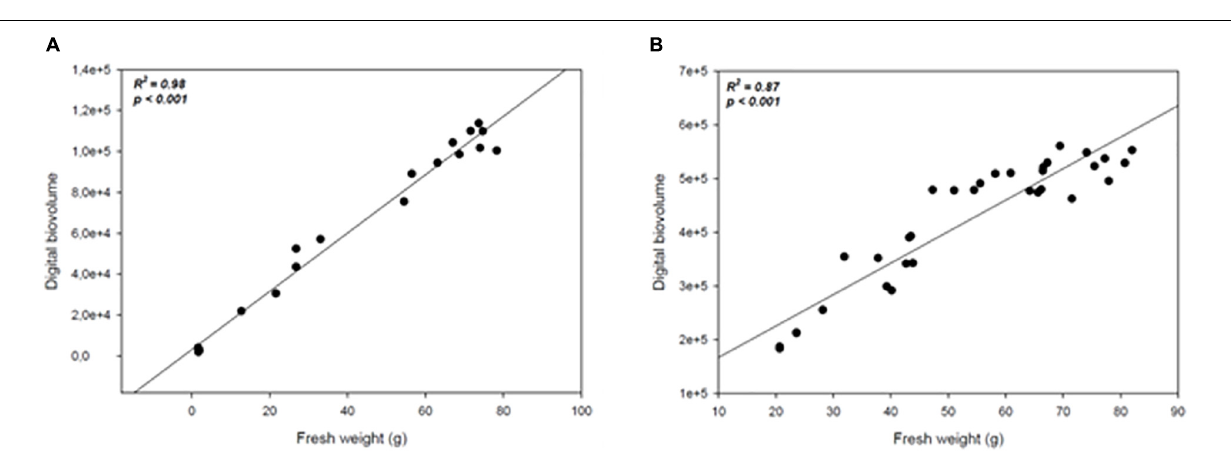
FIGURE 8 | Scatter plots of the automated (digital biovolume) and manual (fresh weight) measurements in Wheat (A) and Tomato (B) . The scatter plots and linear regressions displayed in (A,B) indicate a strong correlation between the estimated and the manually measured parameters in wheat and tomato plants, with correlation coefficients of 0.98 and 0.87 respectively to the plants’ fresh